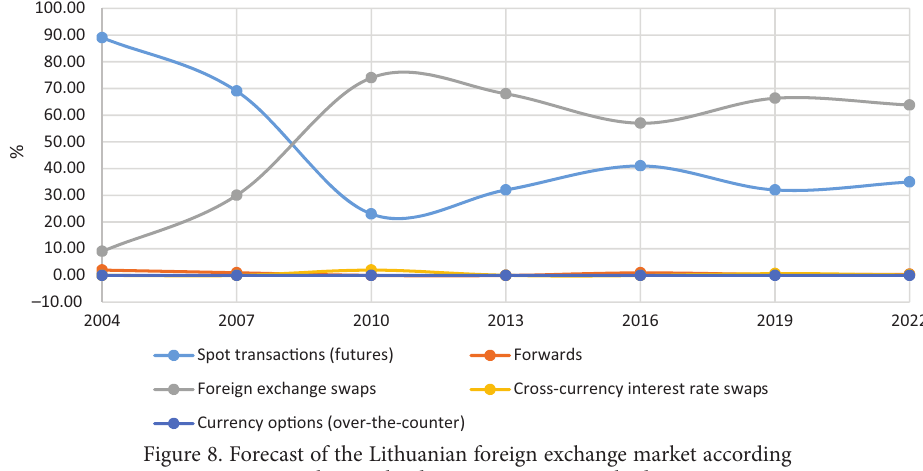
Figure 8. Forecast of the Lithuanian foreign exchange market according to the weighted moving average method (source: developed by the authors based on LB, 2016, 2018, 2019b; BIS, 2018a,